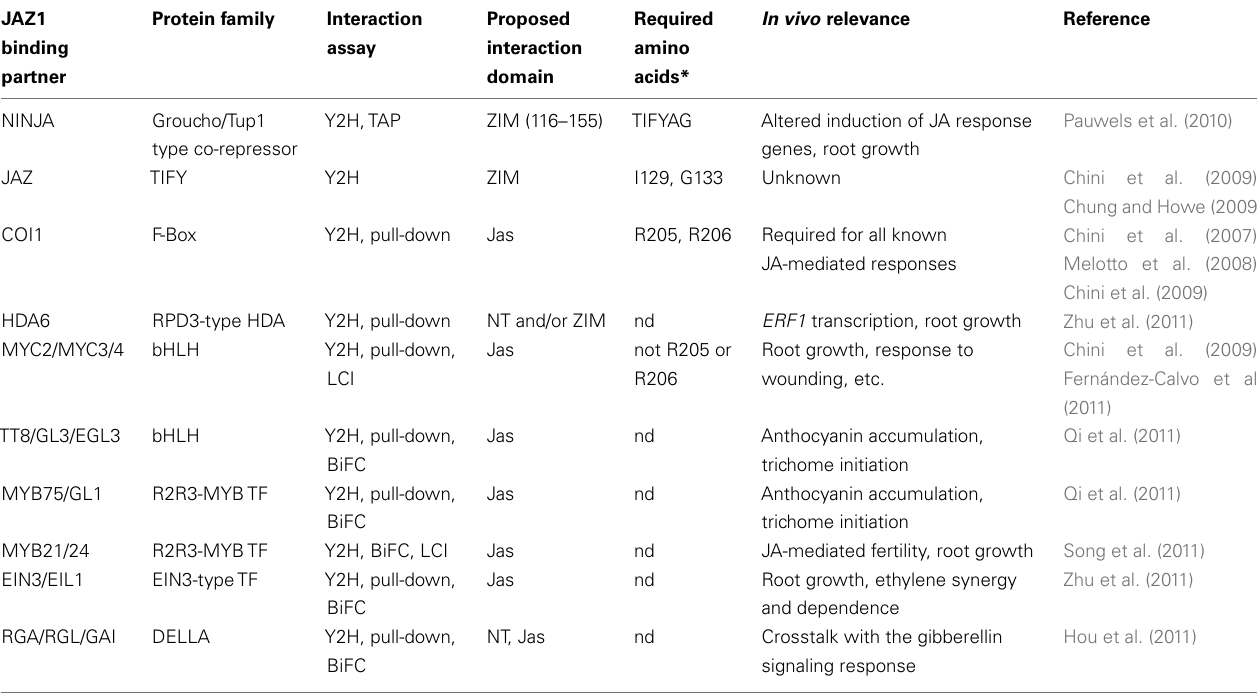
Table 1 | Summary of our current knowledge of the protein–protein interactions in which one or more members of the JAZ family are